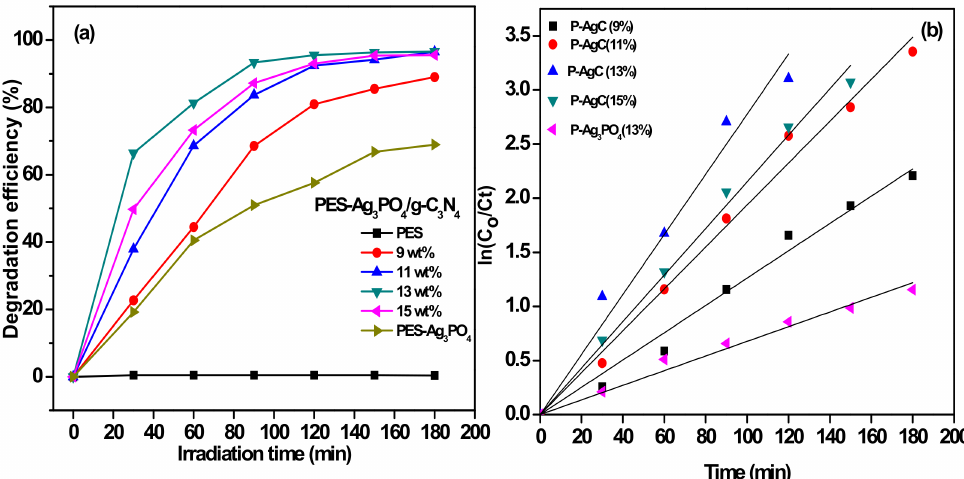
Figure 8. ( a ) Degradation efficiency and ( b ) kinetic study of the degradation of MO by the P-AgC photocatalyst films with different Ag 3 PO 4 /g-C 3 N 4 content (0–15 wt %) (volume of MO: 0.3 L, number of the film: 2 films, MO concentration: 10 mg/L). Table 2. Kinetic data and amount of MO degraded by the P-AgC photocatalyst films.